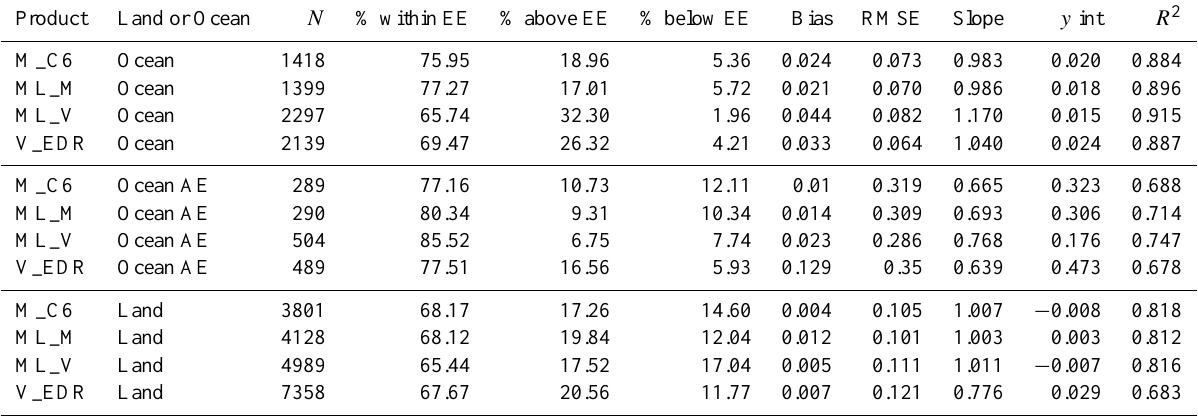
Table 6. Validation of QA-filtered AOD and AE at 0.55µm, compared to collocated ground-based AERONET observations, for the period March 2013–February 2014. EE for AOD is ( + 0.04 + 10%; − 0.02–10%) over ocean and ± (0.05 + 15%) over land. EE for AE as ± 0.4, and requires that satellite-retrieved AOD > 0 . 20. Statistics are for linear regression of the N points.